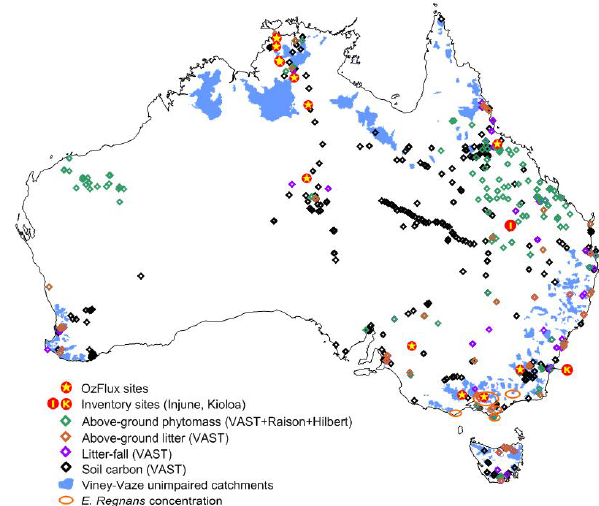
Fig. 1. Bioclimatic classification for use in regionalisation of re- sults.